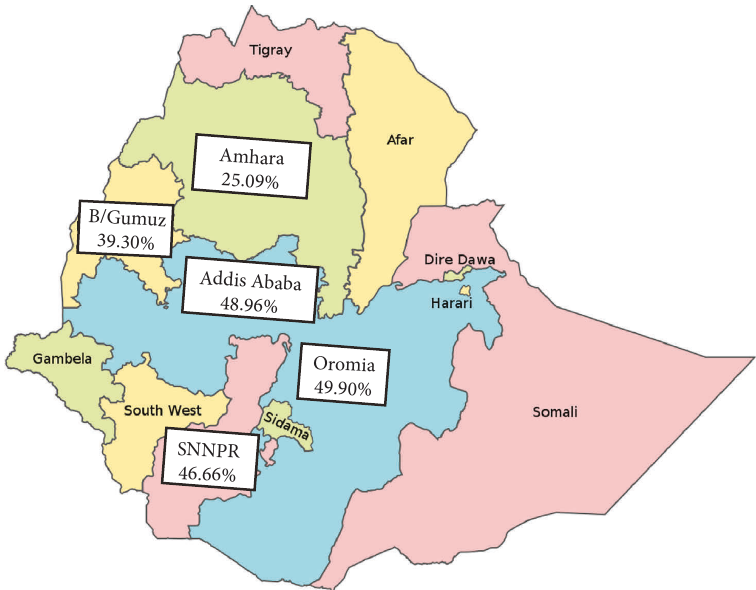
Figure 4: Pooled regional distribution of bovine mastitis among dairy cows in Ethiopia.